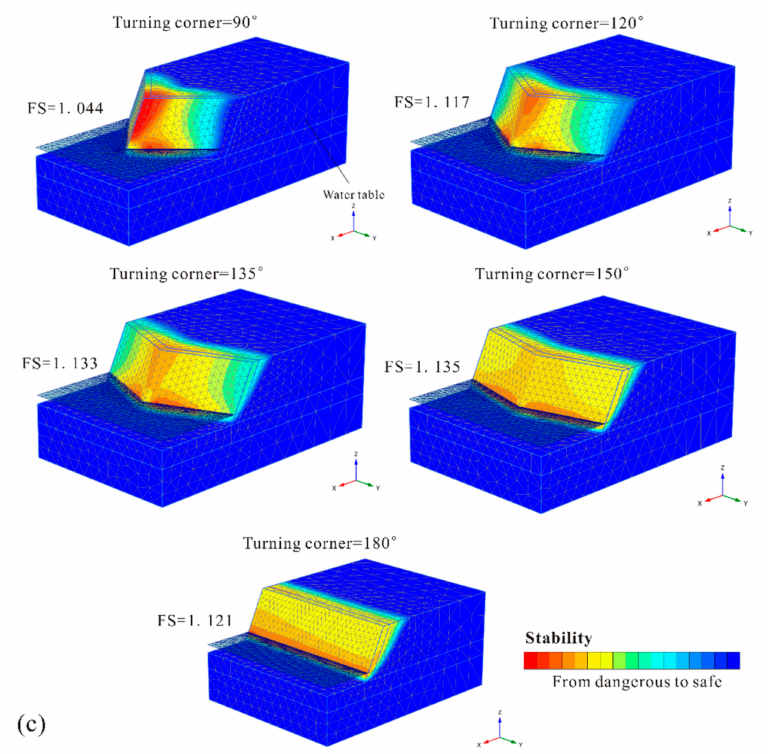
Figure 7. The failure mechanism of convex-shaped slopes with di ff erent corner angles: ( a ) gentle slope gradient of 1:2; ( b ) steep slope gradient of 1:1 and ( c ) very steep slope gradient of